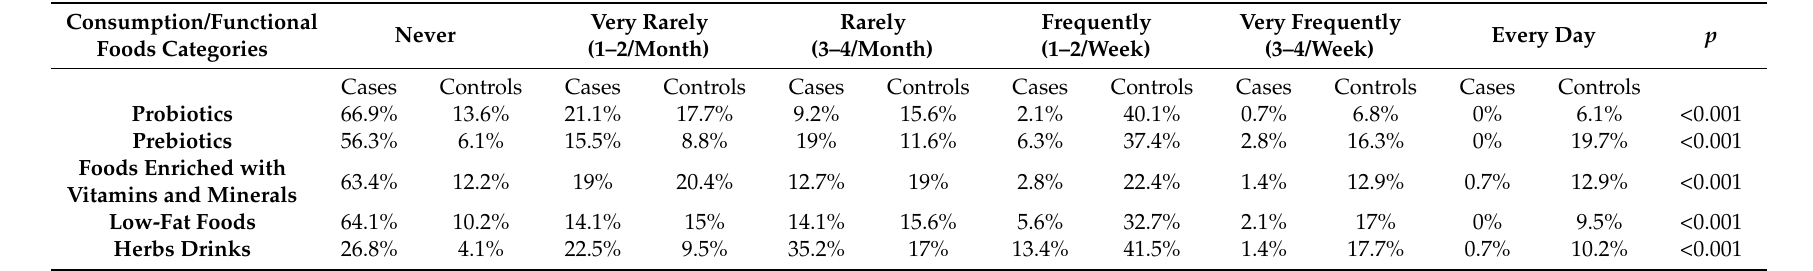
Table 2. Cases–controls comparisons in relation to the consumption frequency of functional foods